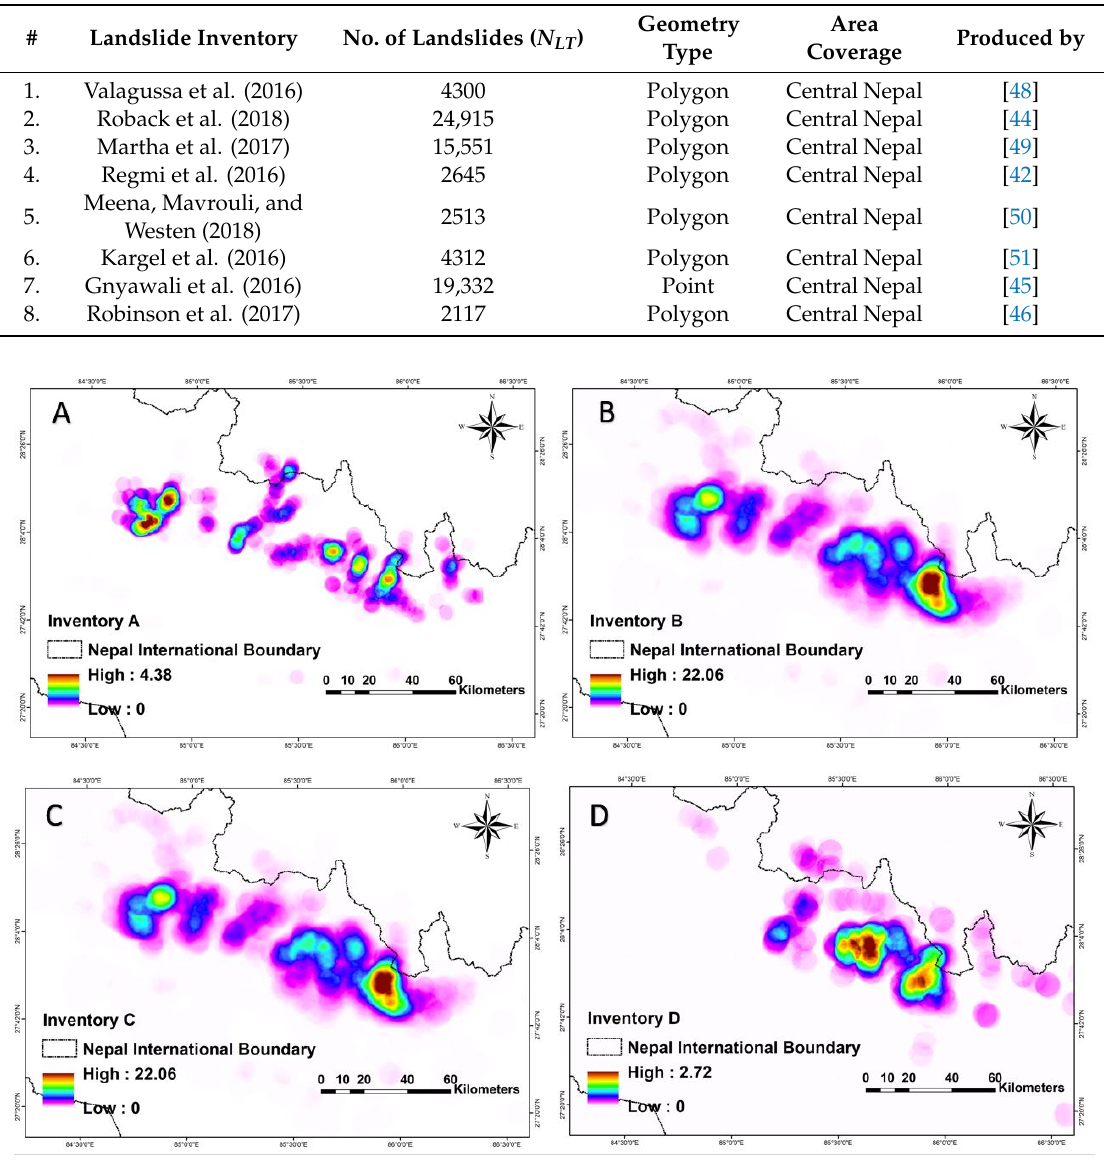
Figure 3. Landslide inventory densities per km ² for the Gorkha event. ( A ) Inventory A, ( B ) inventory B, ( C ) inventory C, and ( D ) inventory D.